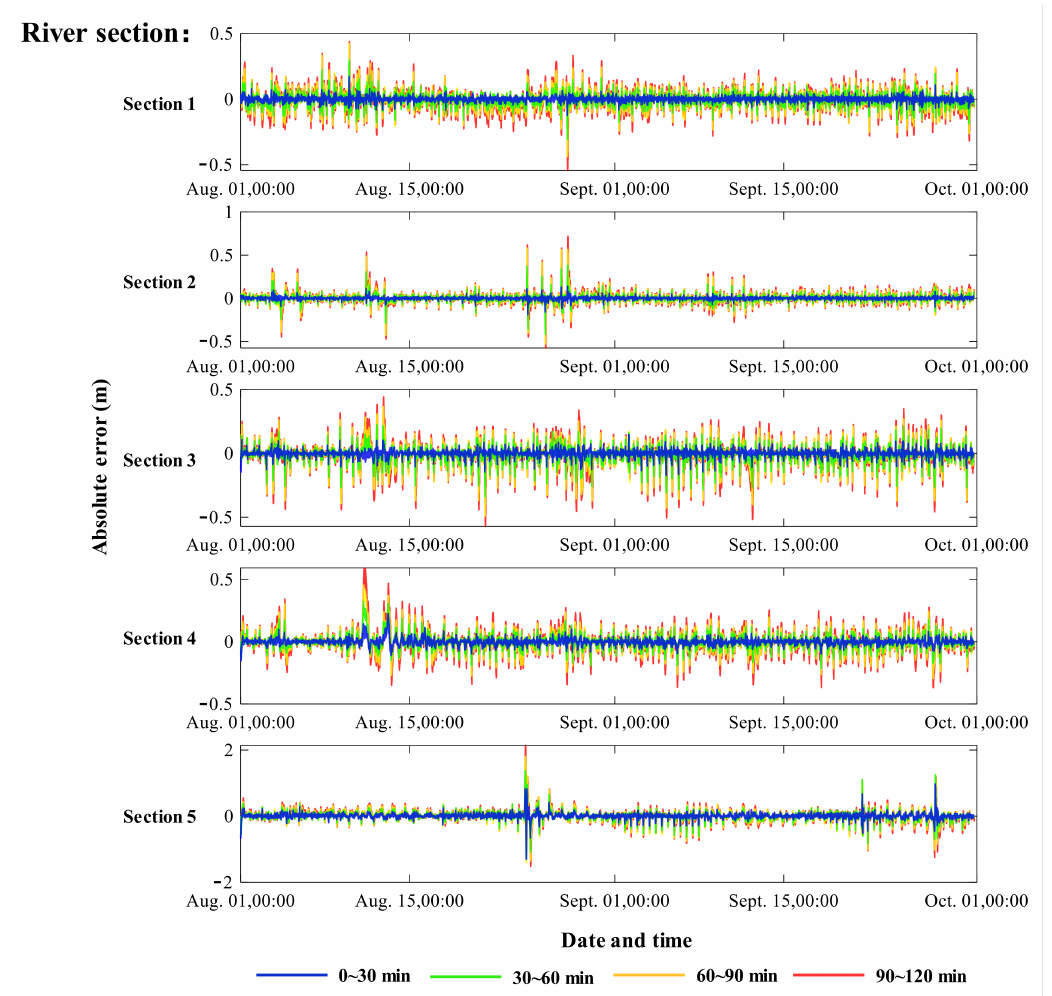
Figure 5. Absolute error between the observed and simulated water